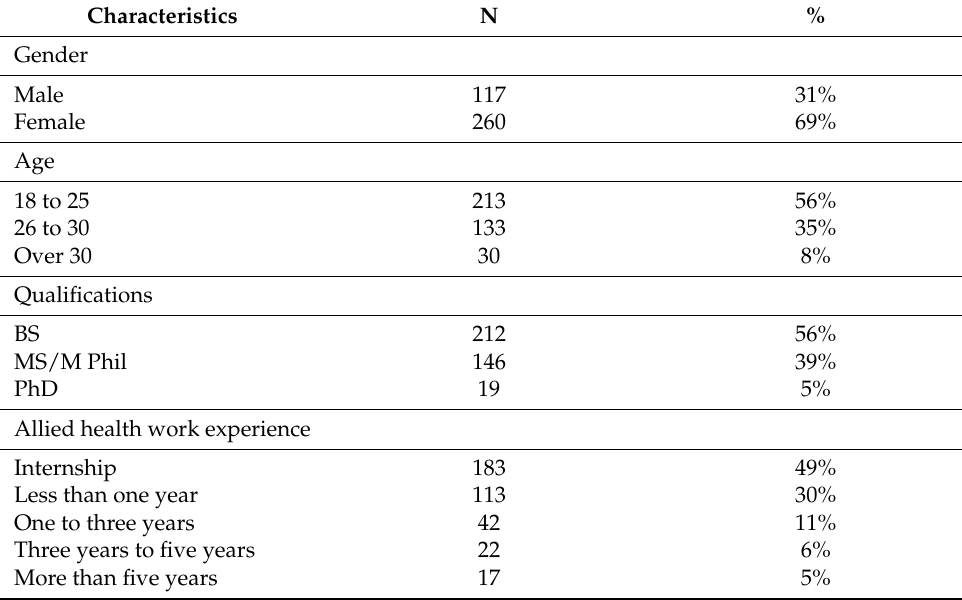
Table 1. Distribution of sample